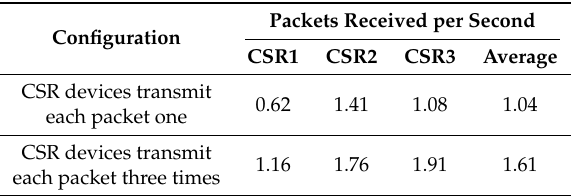
Table 6. Packets per second received by CSR devices in a network with 2 sensor devices and CSR mesh